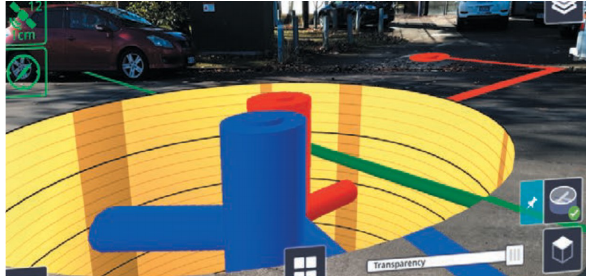
Figure 5. Large virtual model in AR (Trimble, 2021)